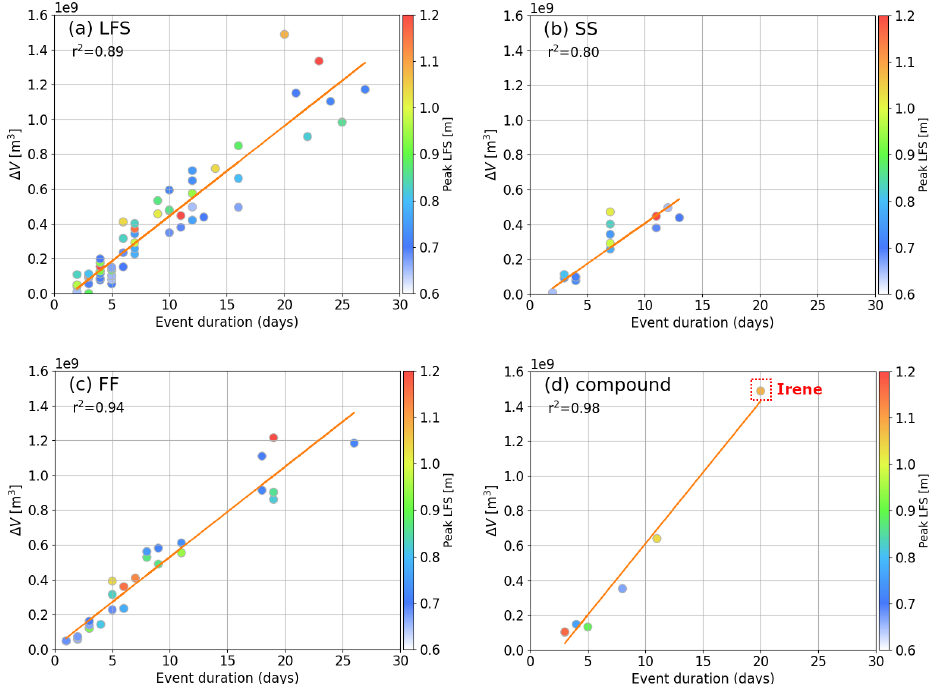
Figure 11. Scatter plot of the accumulated (cid:49)V against the event duration in days for the LFS events (a) , the SS events (b) , the FF events (c) and the compound flood events (d) . The color represents the corresponding peak LFS.